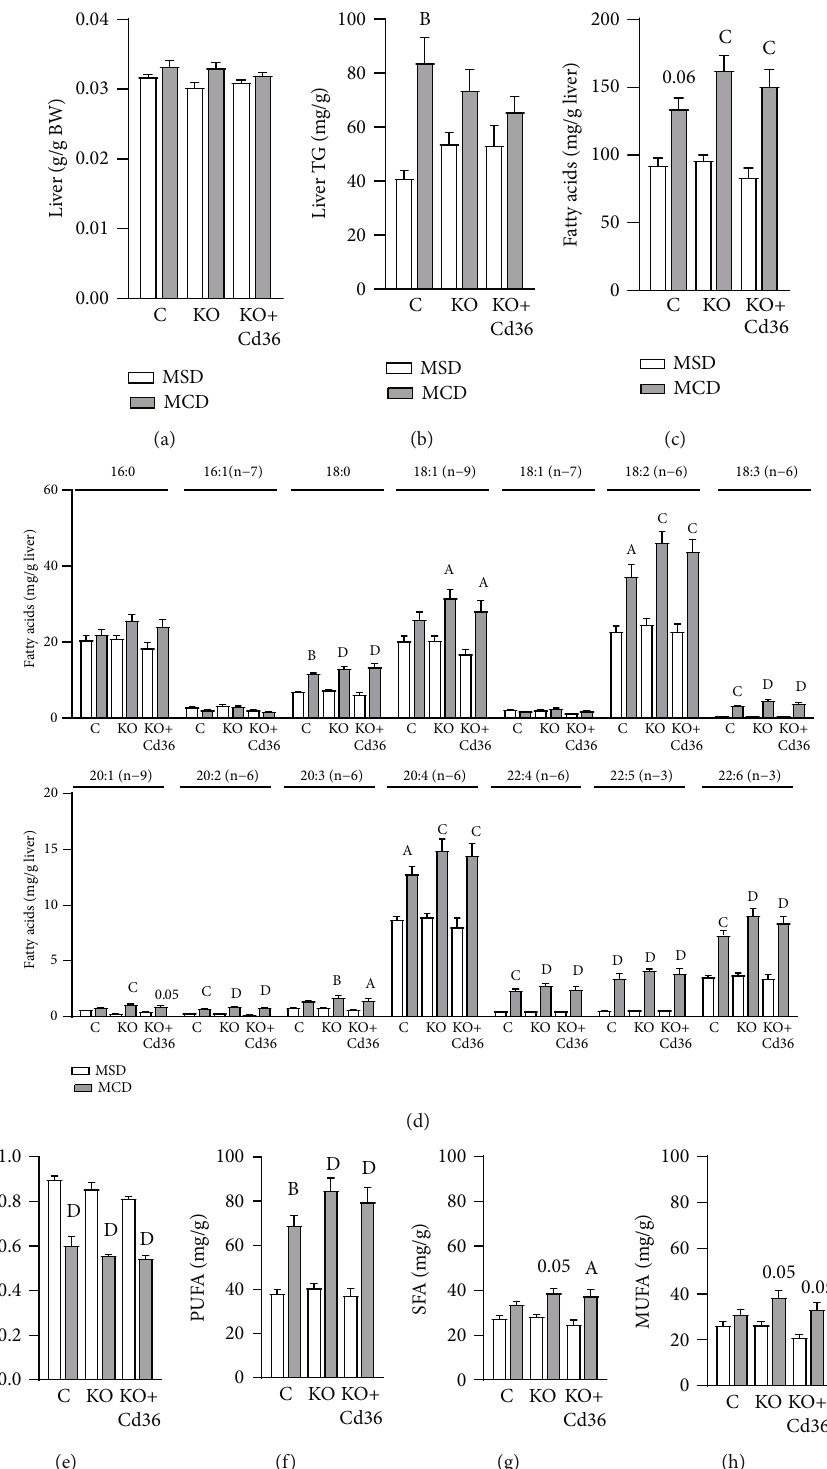
Figure 2: MCD diet increased hepatic polyunsaturated fatty acids independently of hepatocyte PPAR γ and CD36 expression. (a) Relative liver weight. (b) Hepatic triglycerides (Liv TG) levels. Hepatic levels of (c) total fatty acid levels, (d) individual subspecies of fatty acid methyl esters, (e) de novo lipogenesis (DNL: 16/18 :2 ( n ‐ 6 )) index, (f) saturated fatty acids (SFA), (g) monounsaturated fatty acids (MUFA), and (h) polyunsaturated fatty acids (PUFA). Values are represented as the mean ± standard error of the mean . Letters represent signi fi cant di ff erences between MSD and MCD within the group. A p < 0 : 05 ; B p < 0 : 01 ; C p < 0 : 001 ; D p < 0 : 0001 . Control mice (C); Pparg Δ Hep mice (KO); Pparg Δ Hep mice with hepatocyte Cd36 overexpression (KO+Cd36). MSD diet: open columns; MCD diet: close columns. n = 5 ‐ 6